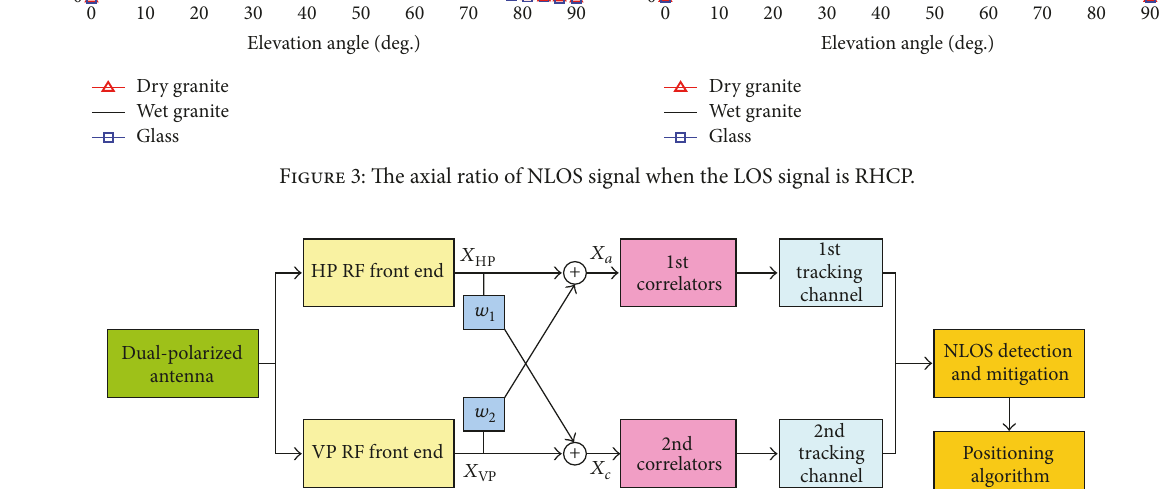
Figure 4: Parallel cross-cancellation receiver with orthogonal dual-polarized